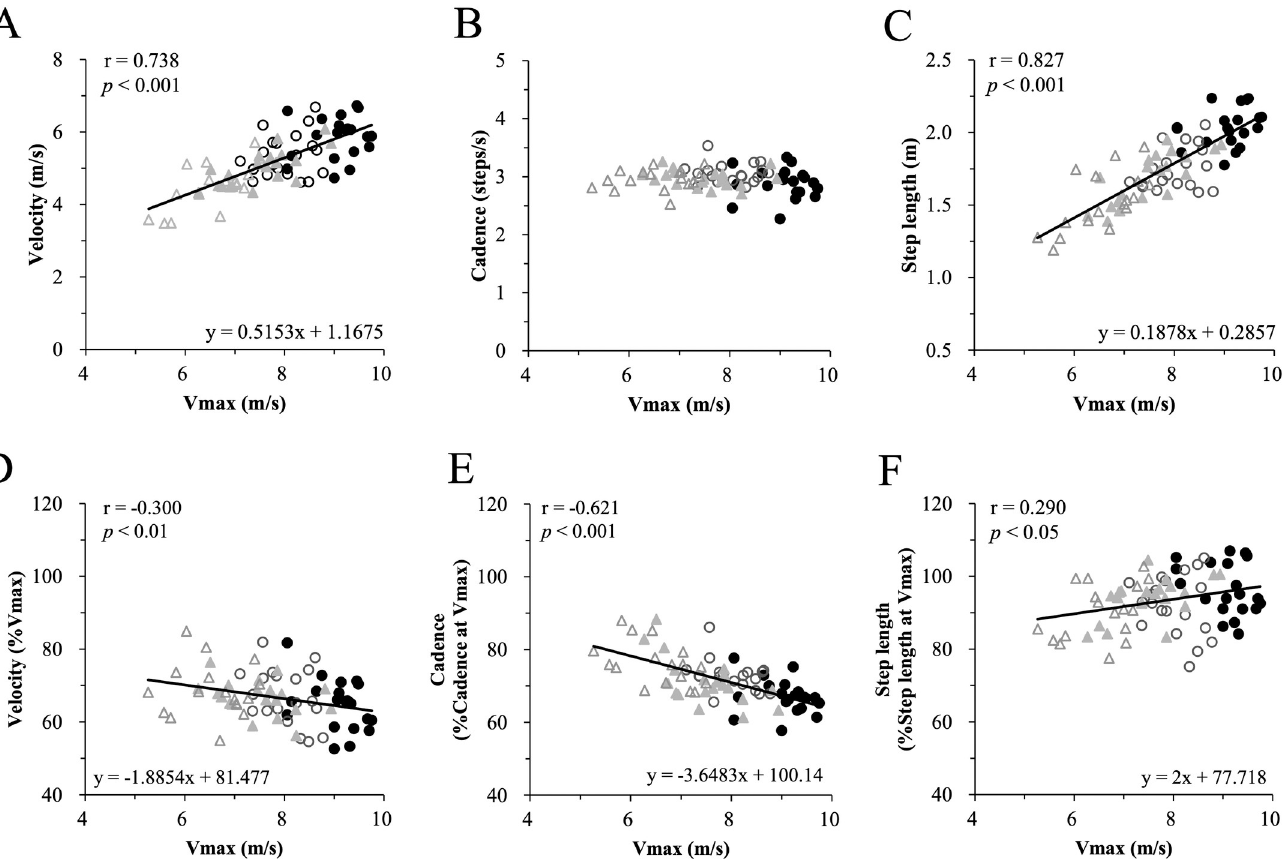
Fig 4. Correlation between maximal running velocity (Vmax) and: running velocity (A), cadence (B), and step length (C), as well as the same three parameters normalized to the Vmax (D–F) at the inflection point. Filled and open circles, and filled and open triangles represent the sprinters, distance runners, active athletes, and sedentary individuals, respectively. The correlations are all significant except for cadence